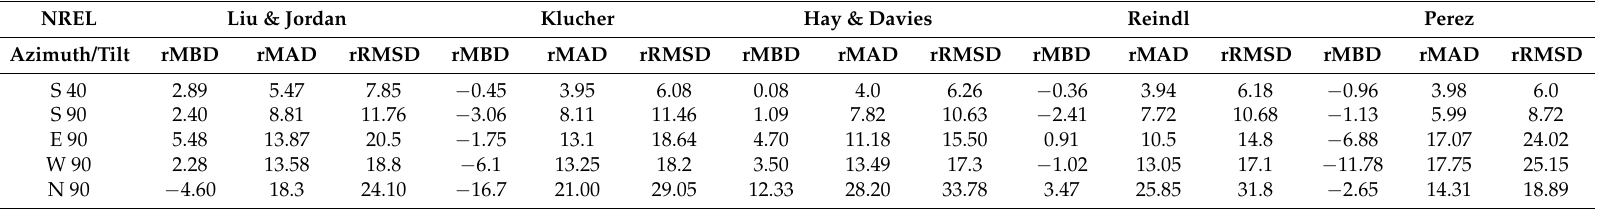
Table 5. Performance of all five transposition models, based on NREL data